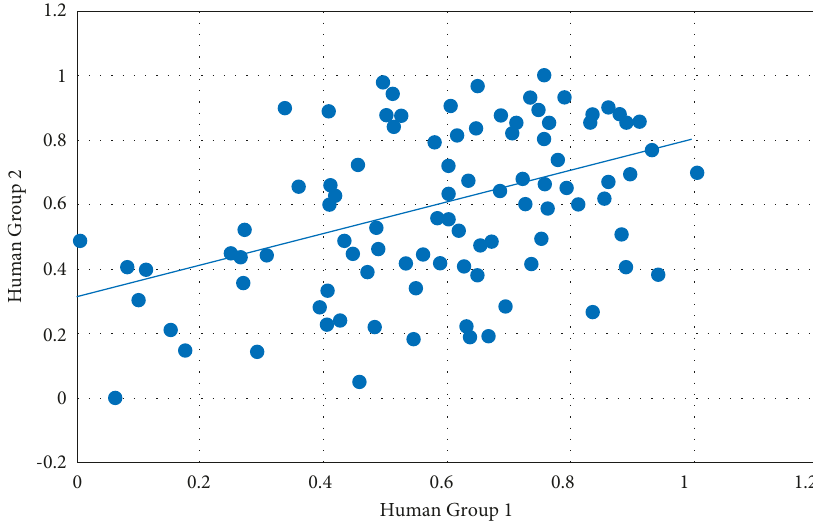
Figure 7: Boys’ predicted endurance performance in 2019. Table 4: Performance table of physical Fitness prediction 2019.